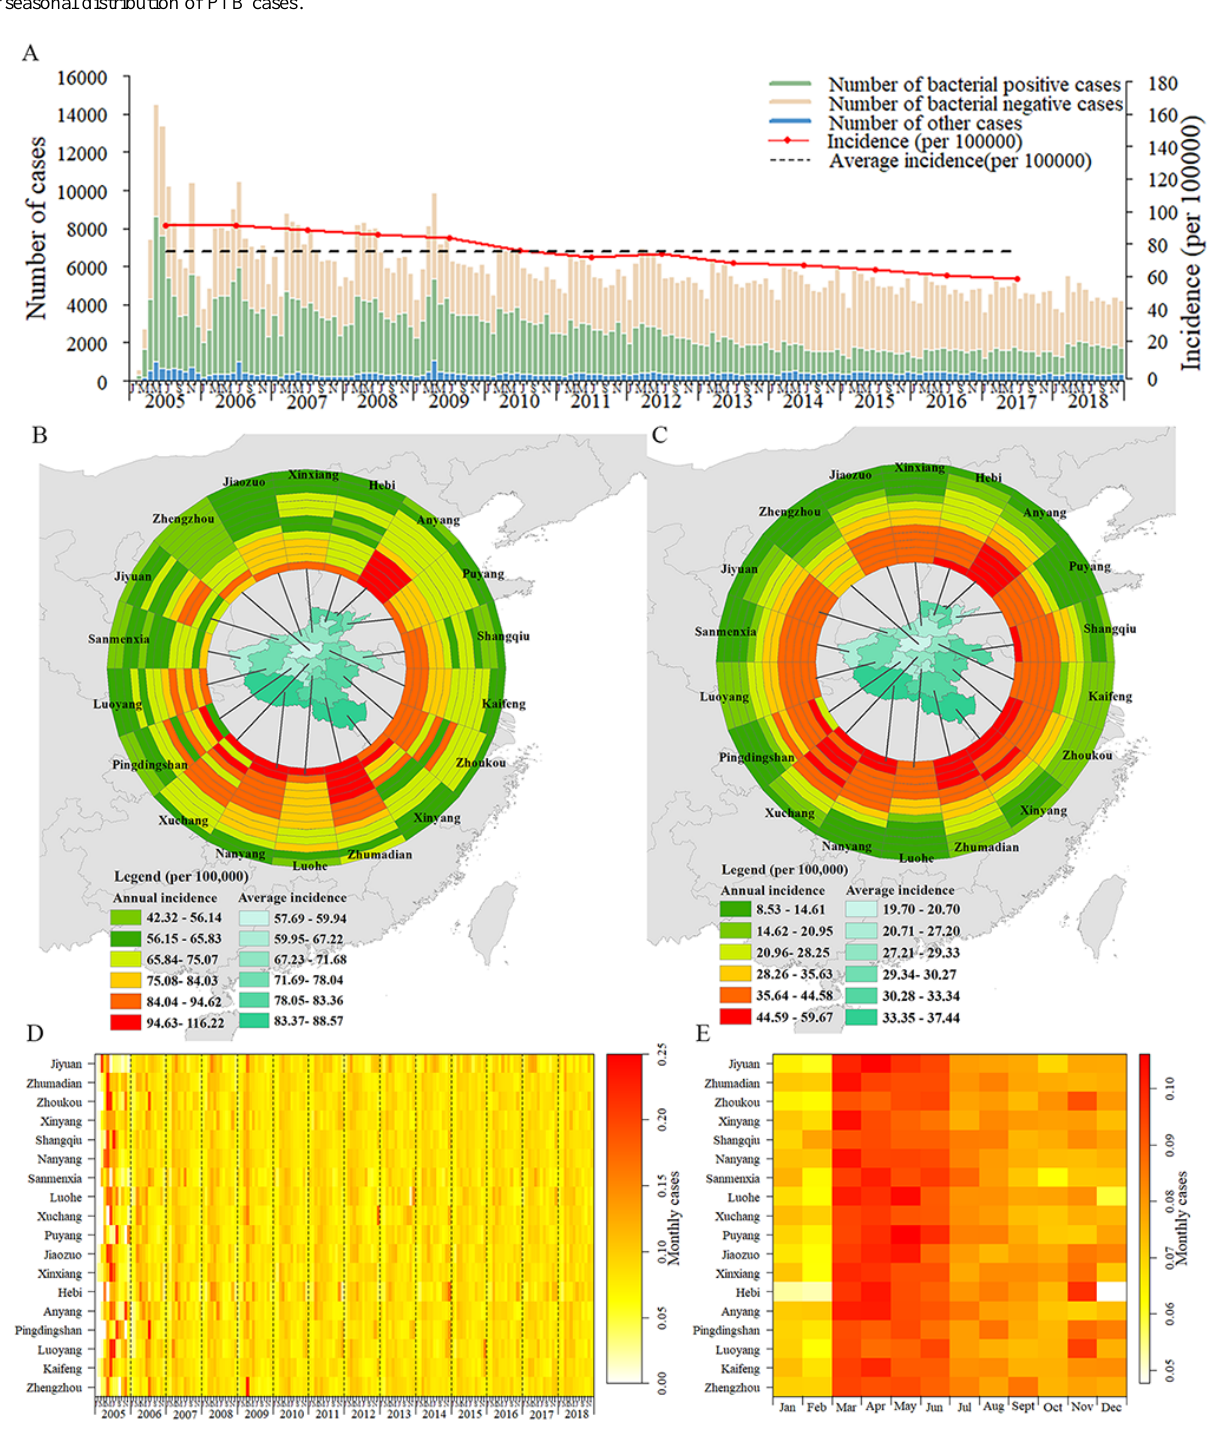
Figure 2. Spatiotemporal distribution of pulmonary tuberculosis (PTB) cases by city and epidemic curve in Henan province, China, from 2005 to 2018. A: PTB epidemic curve on the number of cases reported weekly. B: Spatiotemporal distribution of all PTB cases. C: Spatiotemporal distribution of bacteriological-positive PTB cases. D: Time series for weekly reported PTB cases (standardized by the number of annual cases). E: Cluster analysis for seasonal distribution of PTB